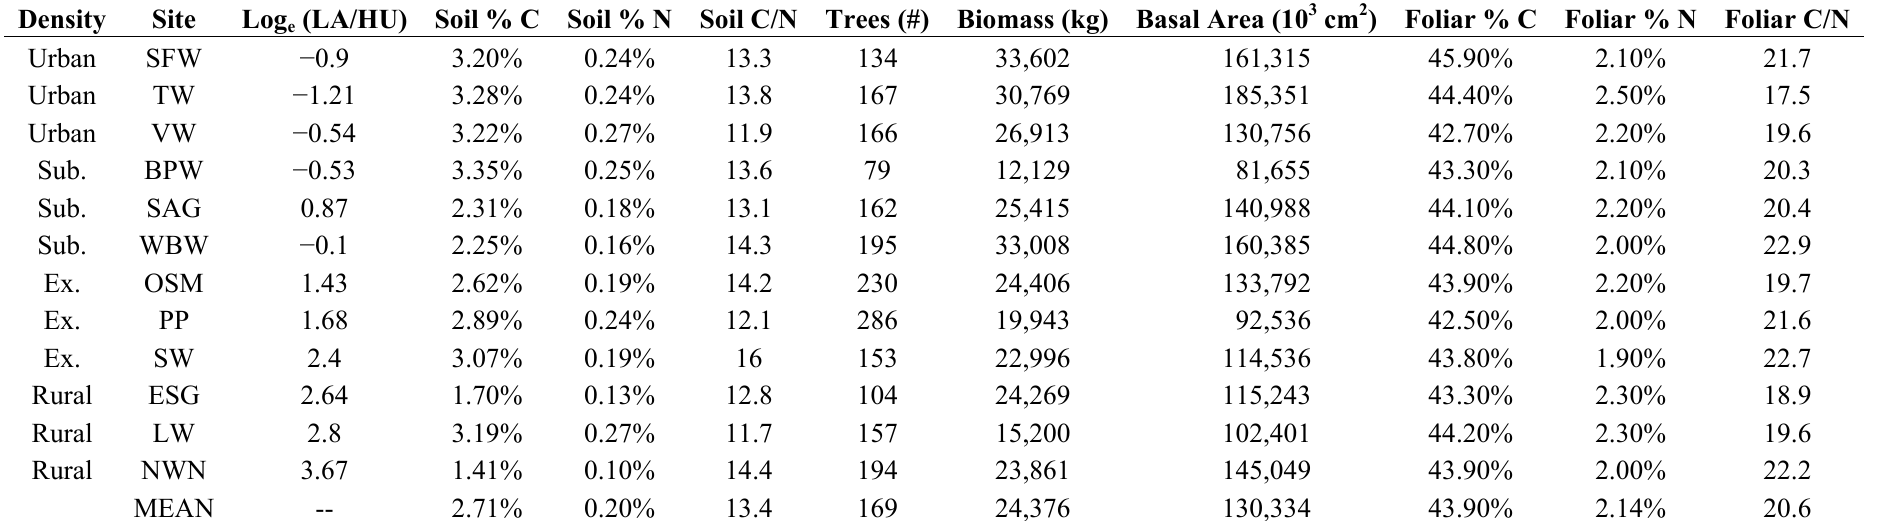
Table 4. Biogeochemistry and Overstory Data Summary by